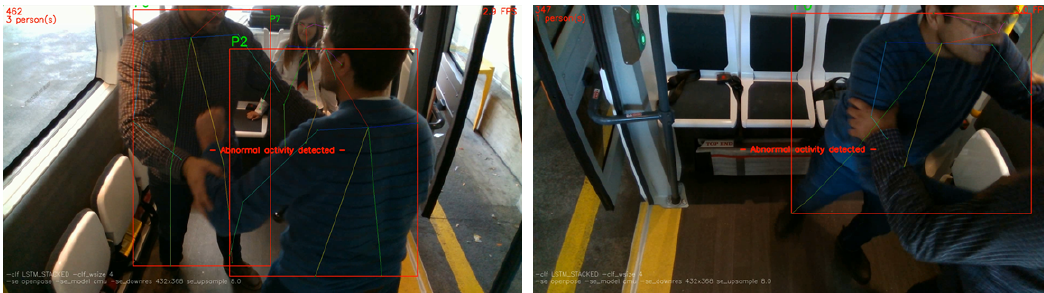
Figure 19. Evaluation on multiple camera angles, excessive occlusion, and partial presence.